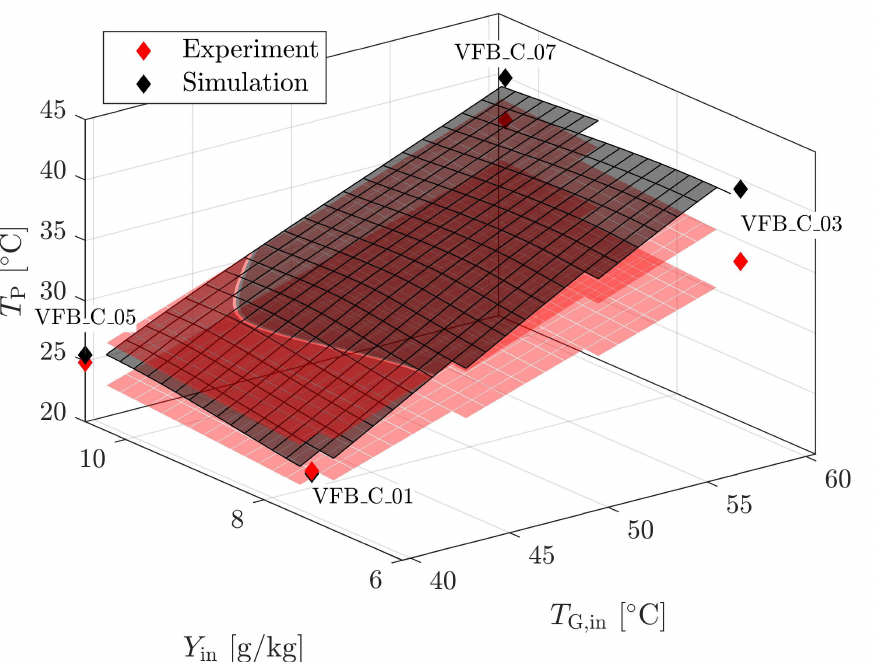
Figure 13. Comparison of measurements and model predictions of particle temperature ( T P ), plot- ted against drying temperature ( T G,in ) and inlet moisture content of air ( Y in ), in the VFB pilot-plant- scale dryer for Cellets. The dark gray area designates model predictions; light red areas indicate the upper and lower boundary of measurement errors. Detailed information about the process conditions of the represented data points is given in Table